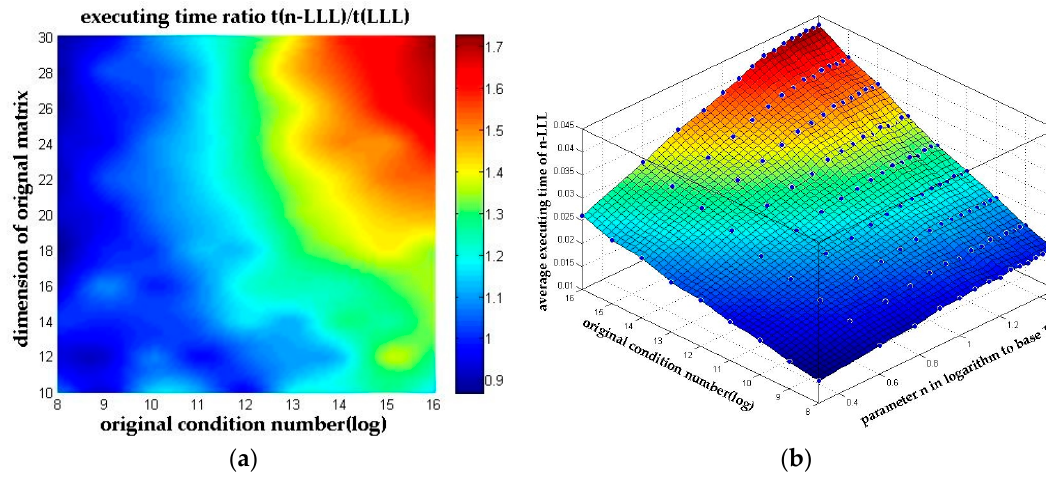
Figure 7. The executing time of n -LLL. ( a ) The executing time ratio between n -LLL and the original LLL algorithm; ( b ) The average executing time of n -LLL with parameter n presented in logarithm to base 10.